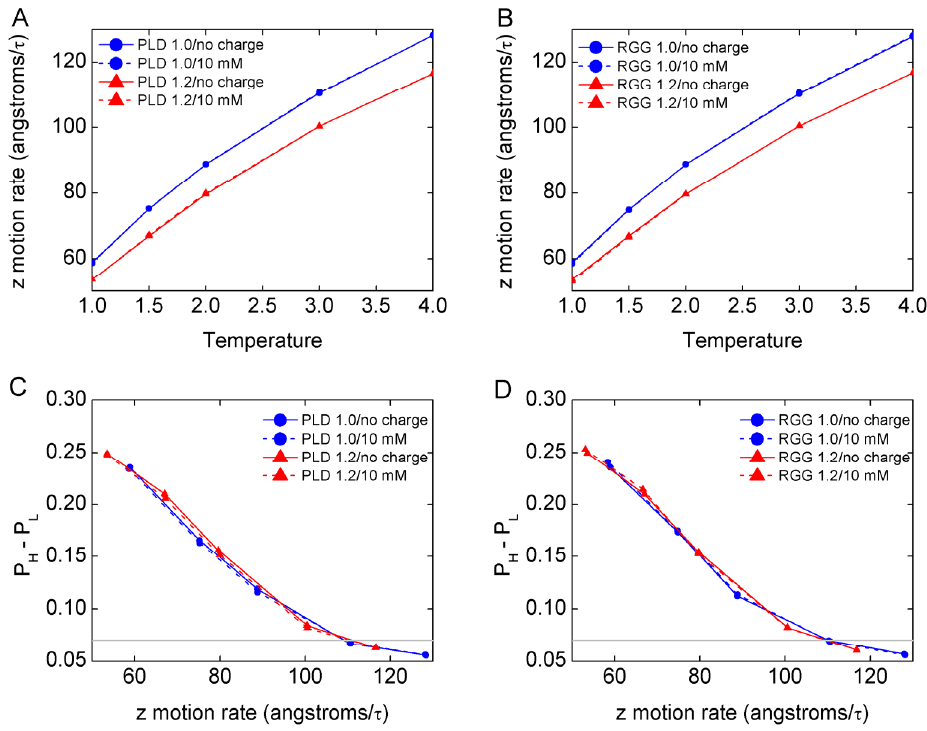
Figure 5. The z motion rate of PLD ( A ) and RGG ( B ) with bead mass 1.0 and 1.2 in different solvents changes with temperature; P H − P L of PLD ( C ) and RGG ( D ) with bead mass 1.0 and 1.2 in different solvents change with z motion rate. The z motion rates are calculated by averaging 200 chains in the box with the last 1000 τ simulation data. The gray line is P H − P L = 0.07. In order to quantify the diffusion of molecules between condensed-phase and dilute- phase, we calculated the average flux of the chains across the boundary line of the con- densed-phase during last 1000 τ time. As shown in Figure 6A,B, the flux increases as tem- perature rises for all models. The flux values of isotope-labeled FUS chains are smaller than that of normal FUS chains at the same temperature. For example, at 2.0 T 0 , the flux of PLD 1.2 chains without charge is 8.6 chains/ τ , lower than that of PLD 1.0 chains (11.2 chains/ τ ). As shown in Figure 6C,D, the P H − P L values decrease as the flux values increase for normal and isotope-labeled models. As shown in Figure S22, we calculated the average flux during the last 100 τ simulation time to confirm that our systems are in equilibrium and the results are reliable. As a result, the flux is strongly correlated with the stability extent of LLPS and lower flux values favor LLPS formation and stability, whose results are equivalent to the z motion rate’s.